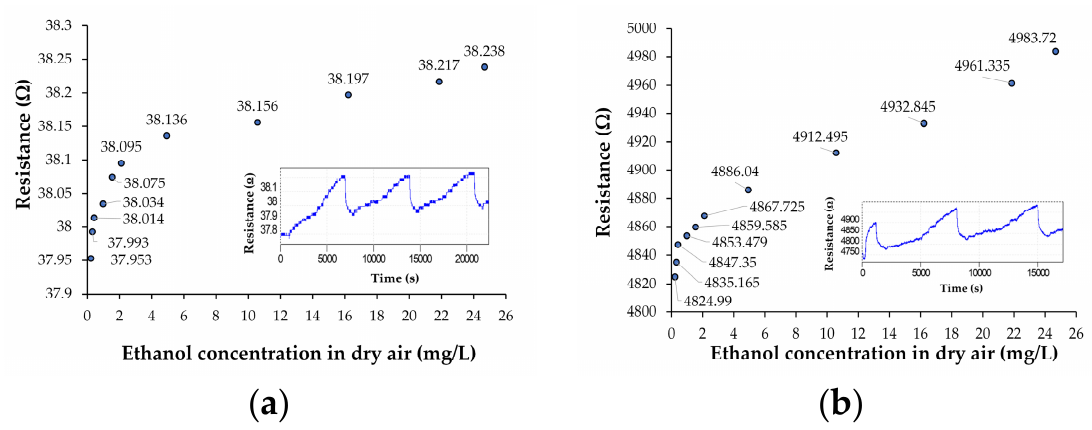
Figure 4. Transfer functions of the chemiresistive ethanol sensors with sensing films kept at room temperature and consisting of ( a ) ox-SWCNH / ZnO / PVP = 5 / 2 / 1 (mass ratio) and ( b ) ox-SWCNH / ZnO / PVP = 5 / 3 / 2. For both cases, the flow rate of air passing through liquid ethanol was varied, while the total flow rate was kept constant at 1 L / min. The inset shows the automatic recording of the sensor resistance as a function of time and ethanol vapor